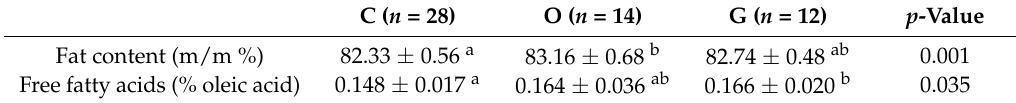
Table 1. Average content ± standard deviation of fat and free fatty acids of conventional (C), organic (O), and grass (G) retail full-fat butters: mean concentration, standard deviation and significant differences between butter types (Kruskal–Wallis).